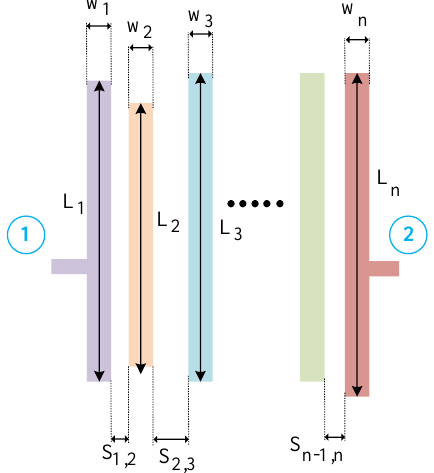
Figure 1. Structure of the typical interdigital